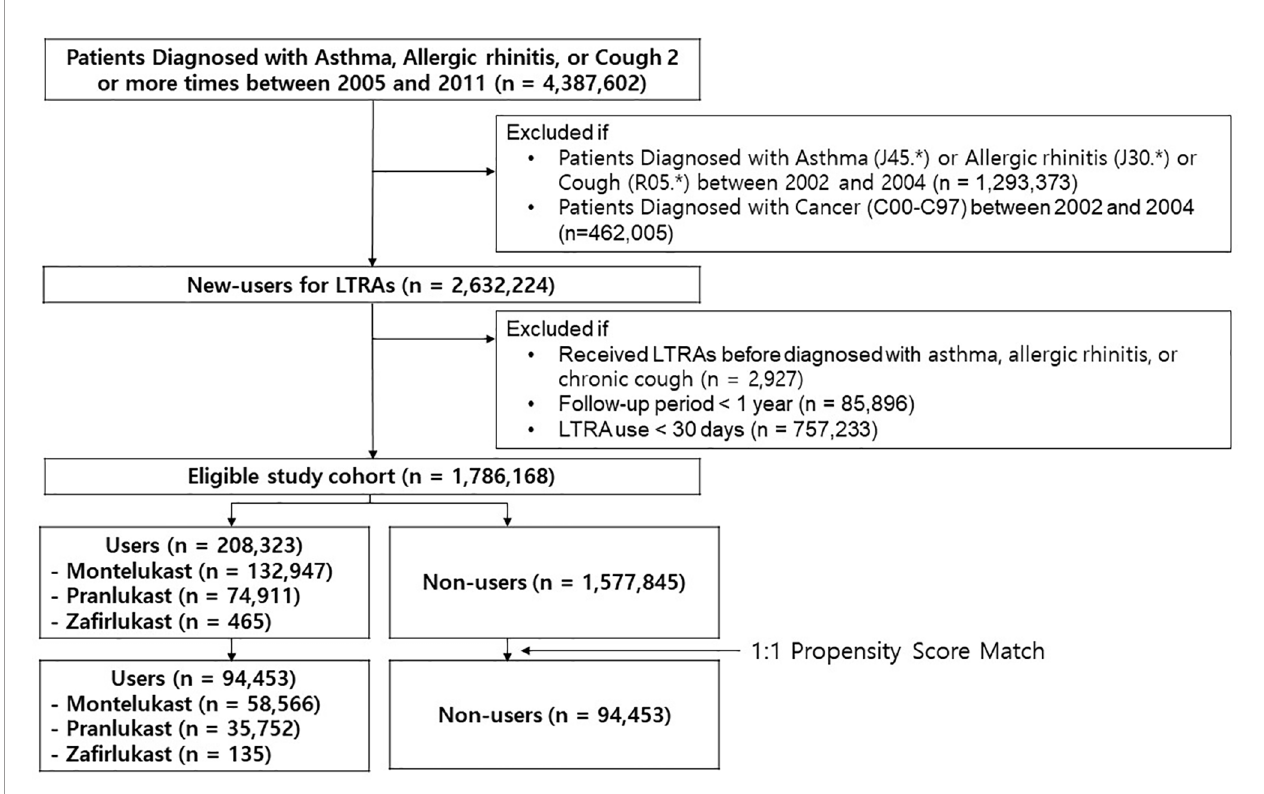
FIGURE 1 | Study fl ow chart. LTRAs, Cysteinyl leukotrienes receptor